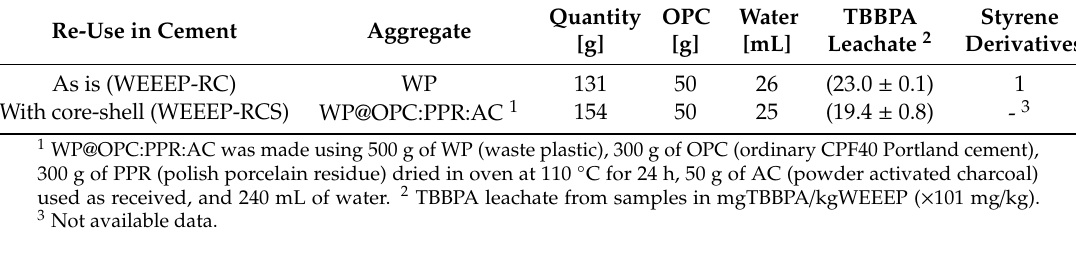
Table 4. Inventory data for e-plastic re-use in cement alternatives. Adaptation from G ó mez et al. [53]. Re-Use in